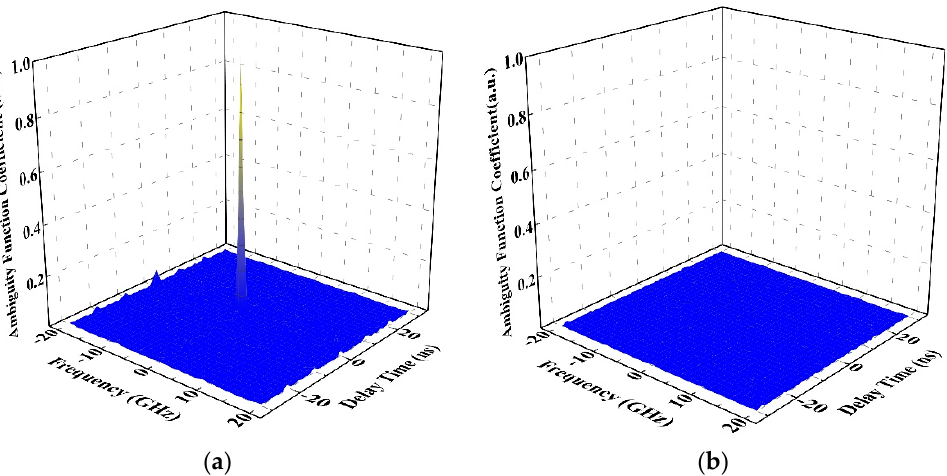
Figure 3. ( a ) An auto-ambiguity function and ( b ) cross-ambiguity function of the transmitted signal.